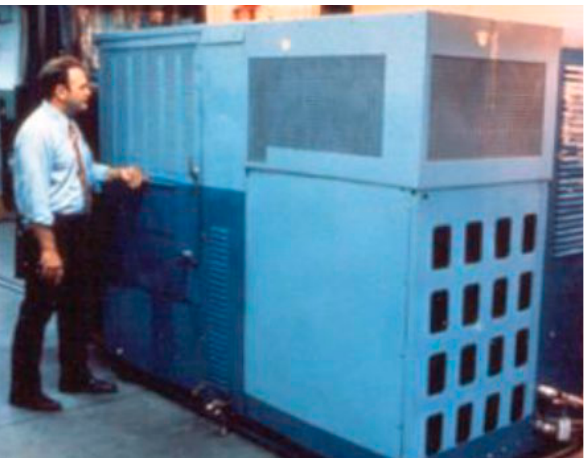
Figure 13. UTC 40 kW model PC-18 phosphoric acid fuel cell, 1979. Courtesy of the US Department of